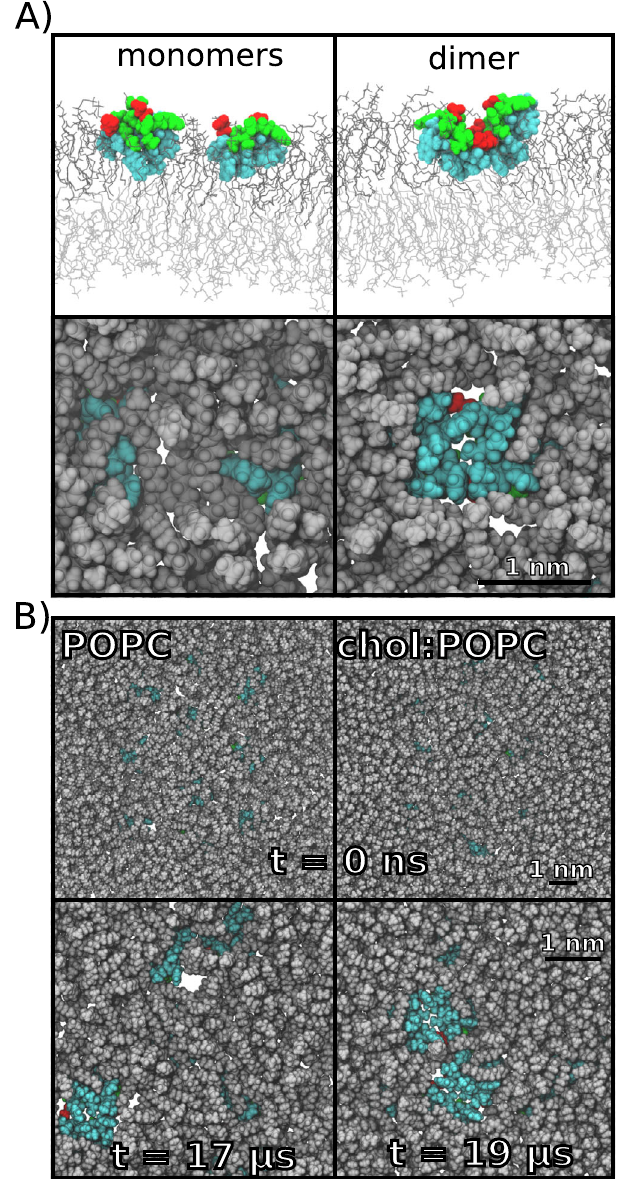
Fig. 5 | Dimersdisplace lipids.A Sideview (top panels) and bottom view (bottom panels) of two FP in POPC when they are isolated (left, t=1 μ s) or in anantiparallel dimer (right, t=15 μ s). Peptides are shown as Van der Waals spheres with hydro- phobic residues in cyan, acidic residues in red, and polar residues in green. In the sideview,toplea fl etlipidsaredepictedasdarkgreylineswhilebottomlea fl etlipids are in lighter grey. In the bottom-up view, only lipids in the top lea fl et are shown, and they are depicted as grey spheres. B Same view as above, but for the entire POPC(left)andchol:POPC(right)lea fl etsatt=0whenthepeptidesareisolated.As peptides cluster over the course of the simulations, lipid displacement becomes more pronounced. Lipid displacement was observed whenever clustering occur- red. The undersides of the three dimers at 17 μ s are shown for POPC (left), and for the hexamerat19 μ s in chol:POPC (right);the FPidentitiescan bereadfrom Fig. 4. Black scale bars are 1nm in all